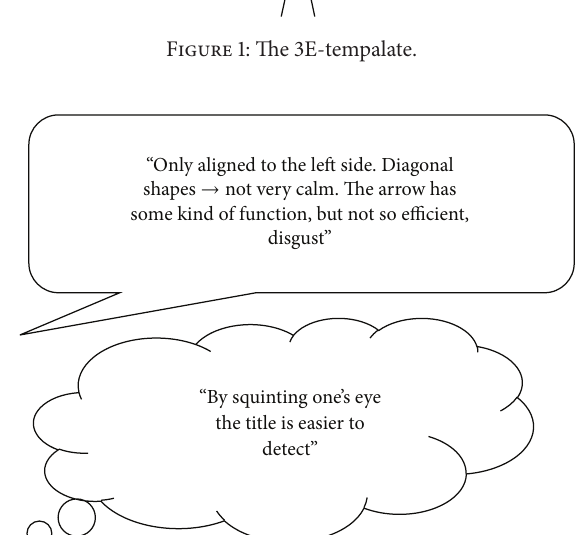
Figure 1: The 3E-tempalate.